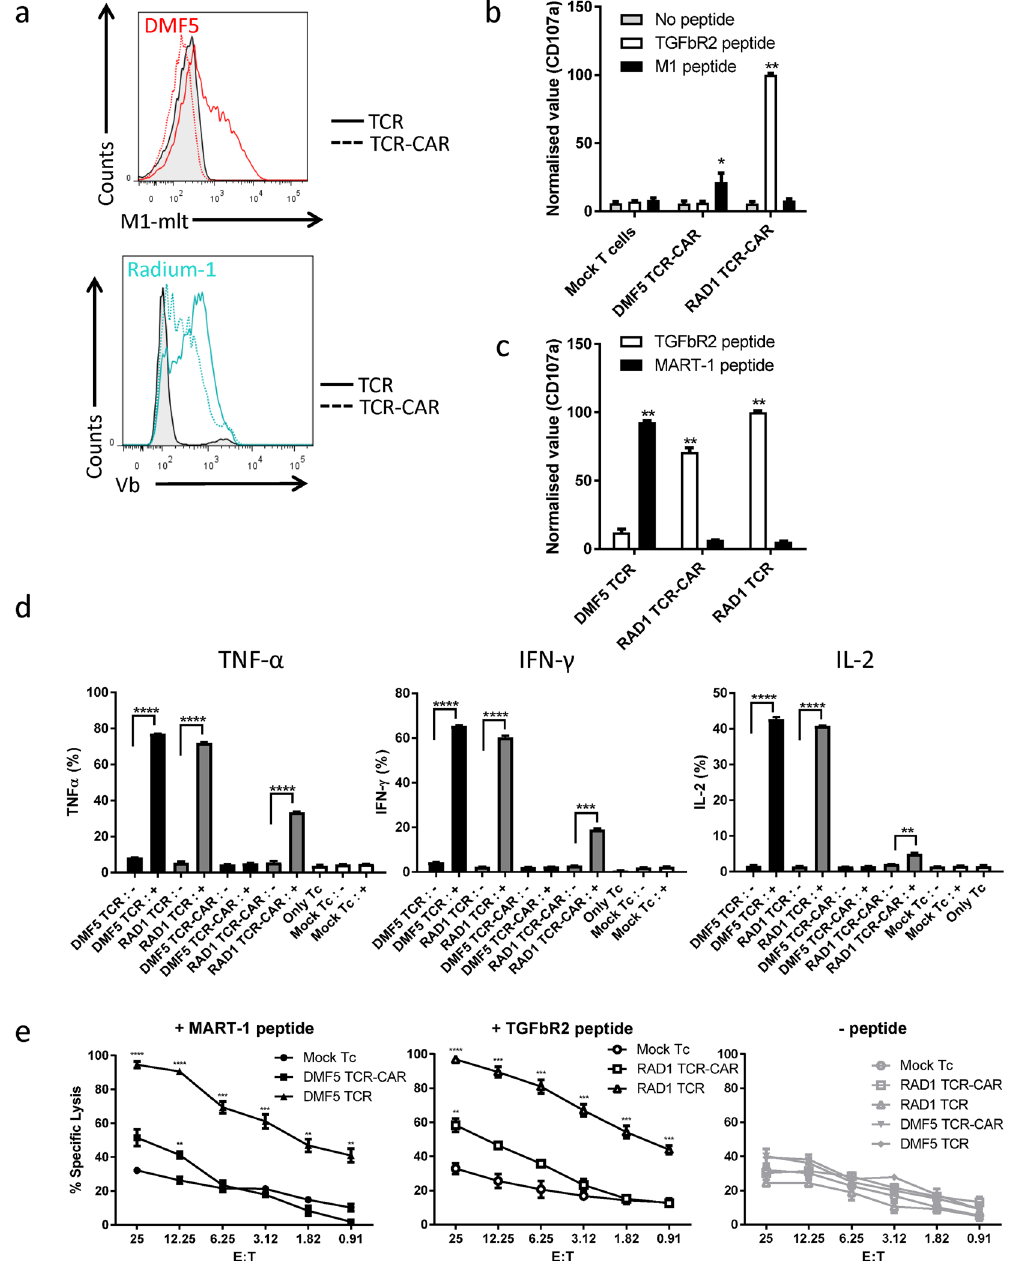
Figure 3. Functional activity of TCR-CAR. ( a ) Primary peripheral T cells isolated from a healthy donor were mock electroporated (tinted) or electroporated with mRNA encoding Radium-1 (blue) or DMF5 (red) constructs. After 12 hours, cells were stained with the indicated antibodies or multimer and analysed by flow cytometry. ( b ) The same cells were co-incubated 18 hours later with APCs loaded with the indicated peptides for 5 hours (grey = no peptide, white = TGFbR2 peptide and black = MART-1 peptide). The presence of the degranulation marker CD107a was performed to monitor T-cell stimulation. Data are representative of two separate experiments. Values were normalized to that of Radium-1 TCR CAR. Mean ± Standard error of the mean (SEM). N = 2. ** P < 0.0001, * P < 0.001, 2-way ANOVA followed by Tukey’s multiple comparison test. ( c ) same as in (b) but here Radium-1 TCR-CAR was compared to the full-length Radium-1 TCR. DMF5 was included as a control for M1 loading. Mean ± SEM, N = 2. ** P < 0.0001, 2-way ANOVA followed by Tukey’s multiple comparison test. ( d ) DMF5 (black) or Radium-1 (grey) TCR-CAR and full-length constructs expressing T cells were analyzed for the indicated cytokine response in the CD8 population. Target cells were loaded ( + ) or not ( − ) with the antigenic peptide and incubated with the T cells at an E:T ratio of 1:2. As a control mock transfected T cells (white) were tested in the same conditions or alone. Intracellular flow cytometry readings were collected after 6 hours of co-culture and % of positive cells were plotted. Mean ± SEM, N = 3. Unpaired t-test was used as statistical analysis. ( e ) same as in ( d ) where specific lysis of target cells loaded with the indicated peptide was analyzed. Transduced Tc with the indicated constructs were